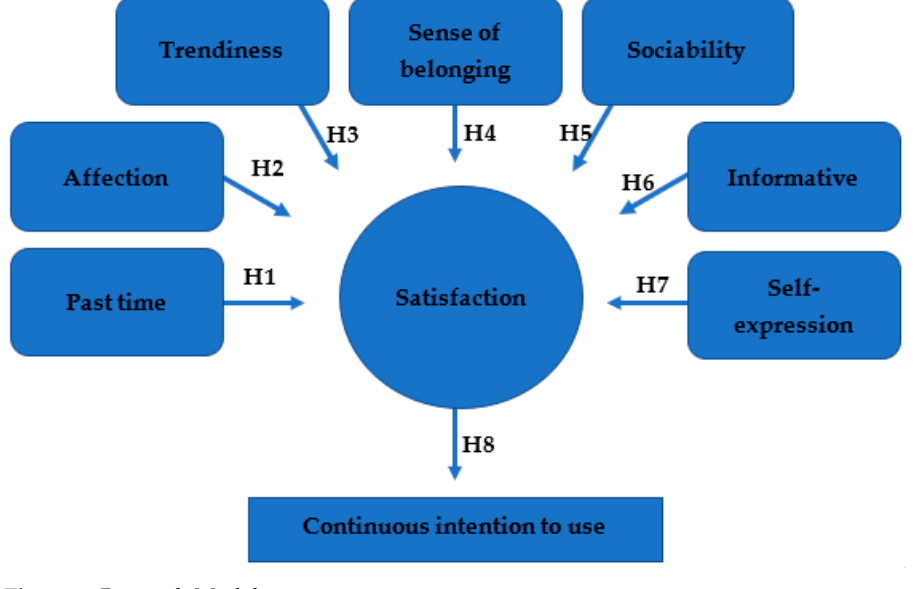
Figure 1. Research